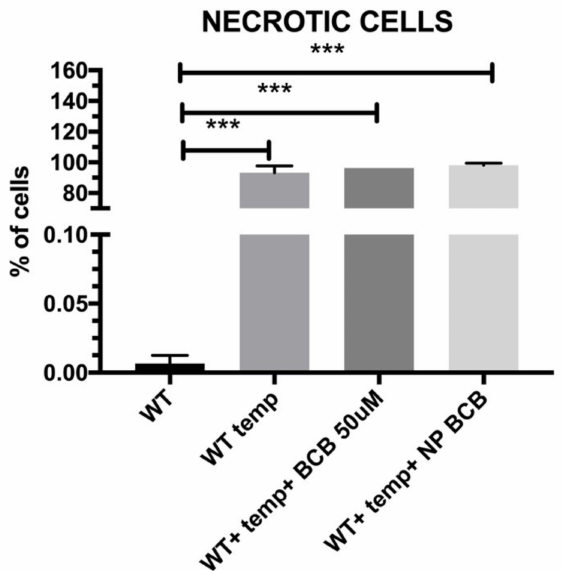
Figure 11. Examination of necrosis in studied populations of WT-SkMCs subjected to high tem- perature, n = 3; WT cells alone; WT cells incubated at 90 ◦ C/10min; SkMCs cells incubated with nanoparticles loaded with BCB and subjected to 90 ◦ C/10 min. Statistical significance legend: p < 0.05 (*), p < 0.01 (**), p < 0.001 (***). Results were obtained using a one-way ANOVA test. Abbrevi- ations: SkMCs—skeletal muscle stem/progenitor cells, WT—wildtype SkMCs, BCB—bax channel blocker, NP BCB–nanoparticles loaded with bax channel